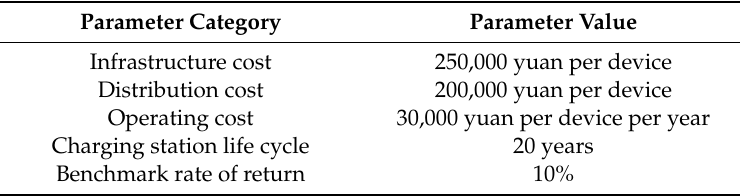
Table 3. Charging station cost